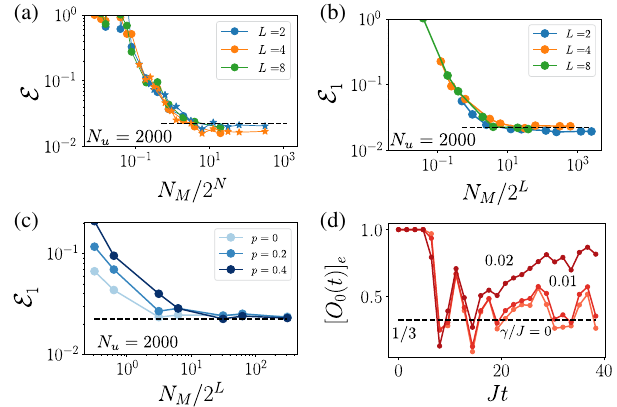
FIG. 7. Statistical errors, imperfections, and decoherence. (a,b) Statistical errors for global and local protocols in the case of the scrambling model, Eqs. (9) and (10). For N M ≫ 2 N (a), resp. N ≫ 2 L (b), the errors reach a statistical plateau at 1 = M the simulations of the global protocols, we use the two values N ¼ 4 , 8 (circles, stars). (c) Effects of depolarization on statistical errors: This decoherence mechanism rescales the values of the observables, which implies that one should perform a slightly larger number of measurements to access O 1 ð t Þ with a given precision. (d) Decoherence vs scrambling in the kicked Ising model. Each qubit is subject to spontaneous emission with rate γ